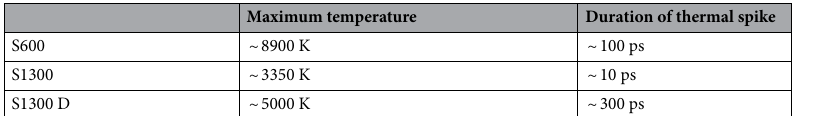
Table 3. Approximate values of maximum transient lattice temperature and duration of thermal spike at the center of the ion track.